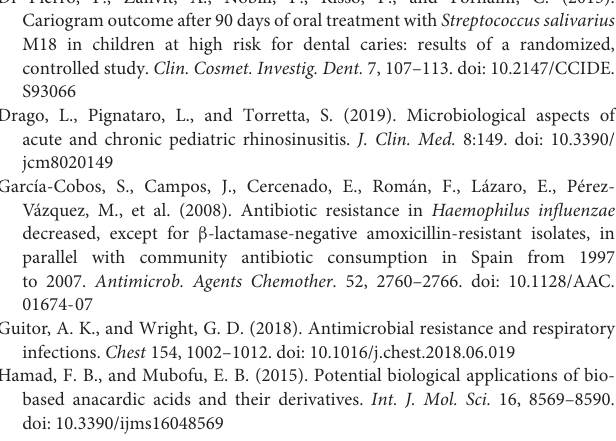
Supplementary Figure 2 | S . salivarius strains K12 (A) and M18 (B) and S . pyogenes (C) in Congo red agar. Supplementary Figure 3 | S . pyogenes in Congo red agar with basal medium (A) and with WLO at 0.39% (B) , 0.78% (C) , 1.56% (D) , and 3.12% (E) . Supplementary Figure 4 | S . salivarius M18 in Congo red agar with basal medium (A) and with WLO at 0.39% (B) , 0.78% (C) , 1.56% (D) , and 3.12%. Supplementary Figure 5 | S . salivarius K12 in Congo red agar with basal medium (A) and with WLO at 0.39% (B) , 0.78% (C) , 1.56% (D) , and